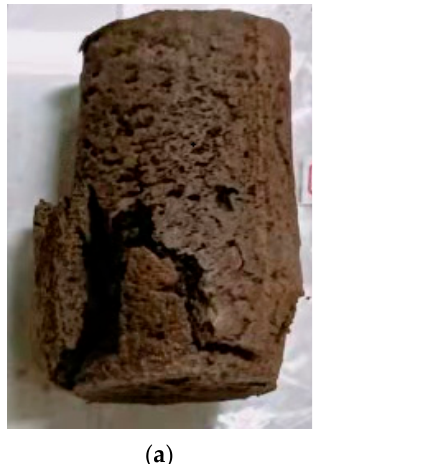
( b ) Figure 10. Damage form ⅲ and ⅳ . ( a ) Damage form ⅲ, ( b ) Damage form ⅳ. Damage form ⅰ : as shown in Figure 9a, the fracture starts from the bottom and gradually diffuses upward. When the diffusion height reaches the middle of the sample, it is completely destroyed. This failure generally occurs when the water content is 10%. When the water content is low, the surface of soil particles is mainly covered by the water in the soil to form a water film. When the pores between soil particles are large, the water film does not directly contact each other to form a connection. The interior of the soil will be smoothly penetrated by the slurry. When the water content increases, the water film is connected and even free water is formed, the channel of slurry penetration is blocked by the water, meanwhile, the water in the soil will be transferred to the lower part under the grouting pressure. The result is that the lower part has less strength than the upper part. Therefore, the damage first appeared in the lower part, and then a larger rupture surface was formed from the bottom up, and finally, the whole soil sample was destroyed. Damage form ⅱ : as shown in Figure 9b, the fracture started from the bottom and diffused upward, and obvious dilatancy occurred in the diffusion process. At this time, the fracture surface continued to spread along the fragile surface inside the soil sample until it penetrated the sample. Generally, when the water content is 15%, the sample will